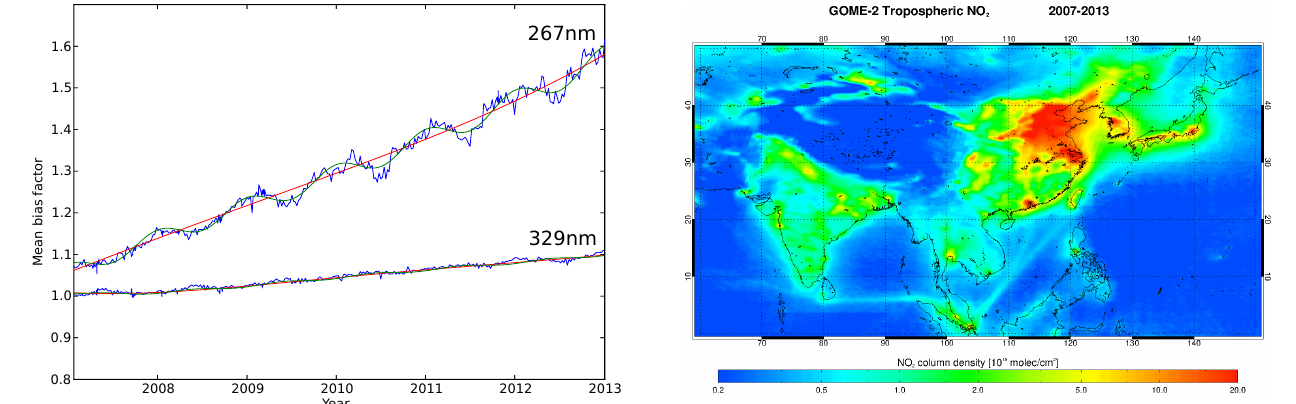
Figure 6. Degradation of the GOME-2A instrument, expressed as the ratio between the measured and simulated spectra (mul- tiplicative bias factor) for 267 and 329nm. The blue lines indi- cate the weekly data points, the green lines are a fitted function (fourier + polynomial), and the red line is a long-term polynomial fit.